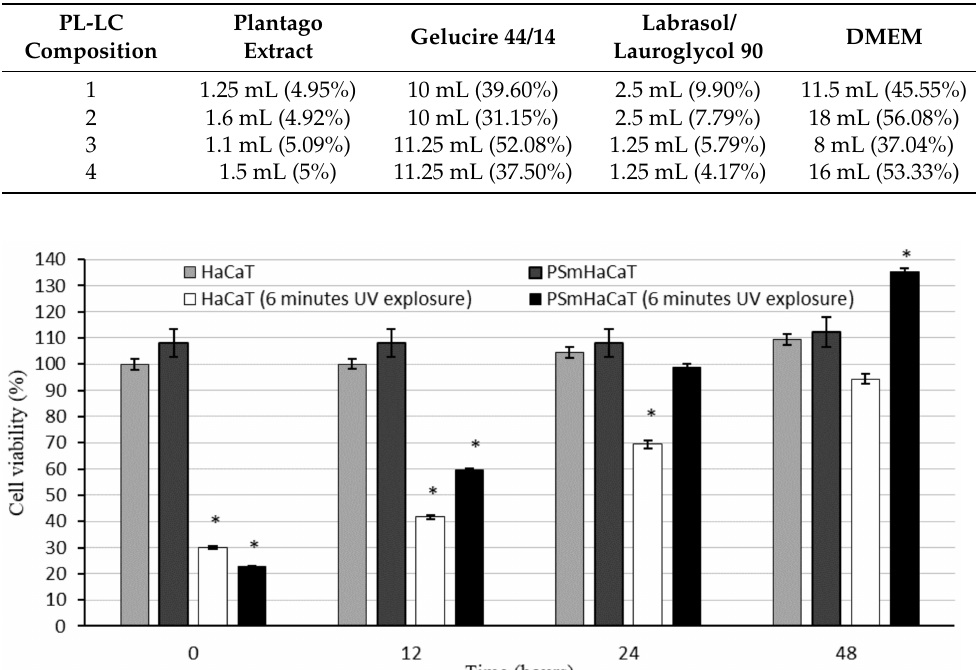
Table 2. Modified compositions of liquid crystals using Dulbecco’s modified eagle’s medium (DMEM) instead of water.